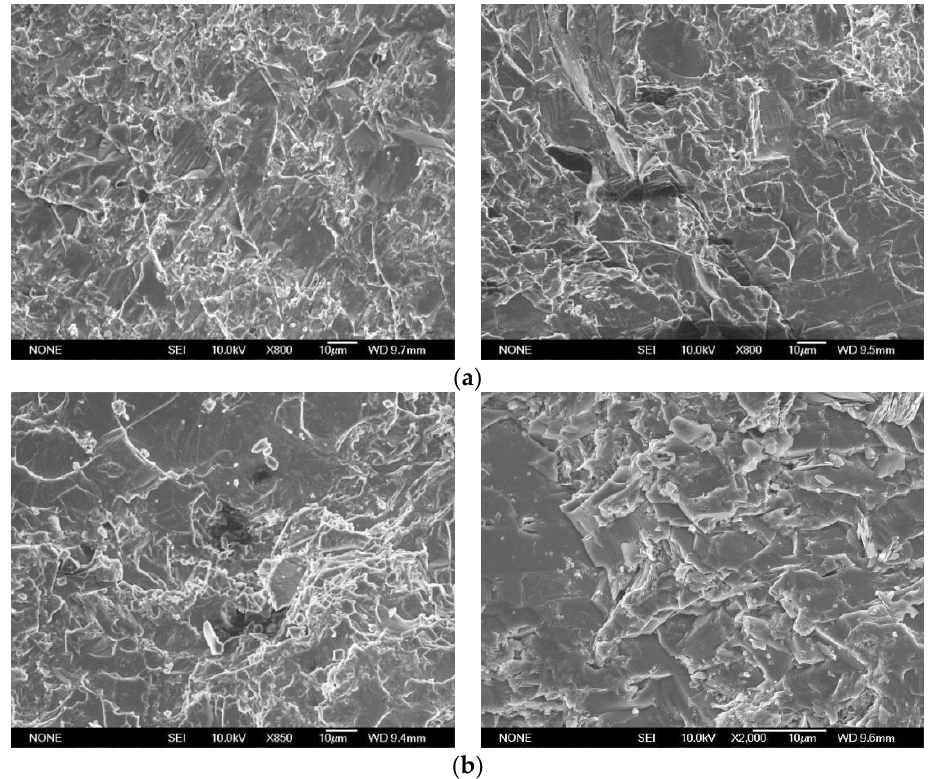
Figure 3. Scanning electron microscopy (SEM) images of pre-existing microcracks and micropores in granite; ( a ) Granodiorite and ( b ) Monzogranite.